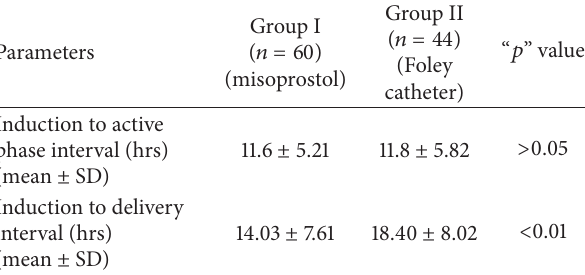
Table 2: Induction to delivery interval (mean ±